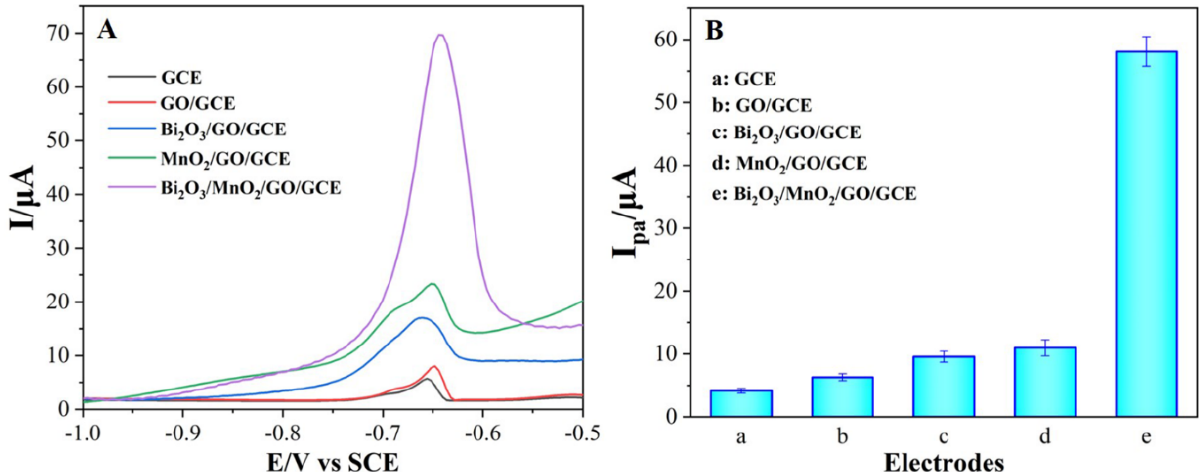
Figure 4. The SWASV curves ( A ) and their respective stripping peak currents ( B ) of Pb 2+ , measured on different electrodes in 10 mL of 0.1 M HAc-NaAc buffer (pH = 5.5) containing 1.0 μ M of Pb 2+ . Deposition was applied at − 1.0 V for 300 s.